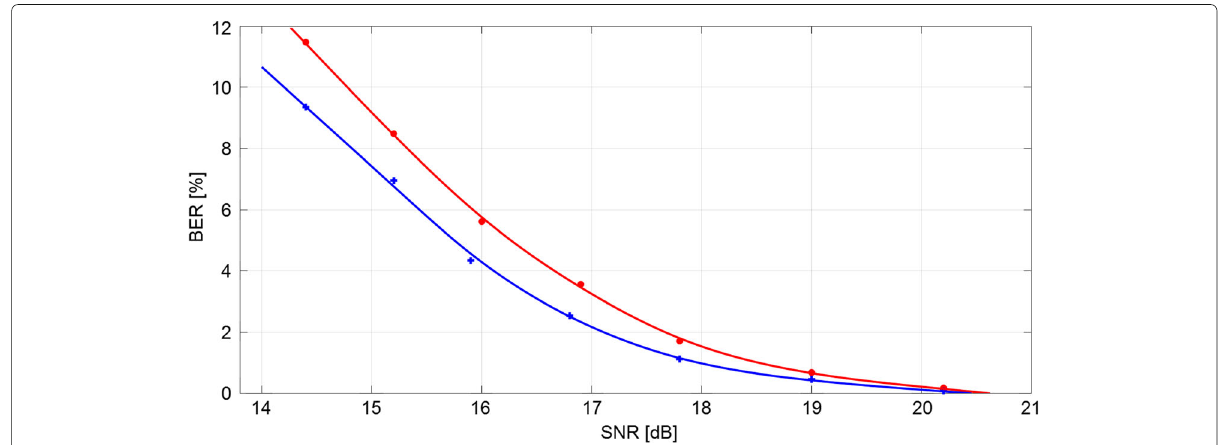
Fig. 1 Perfect reconstruction process: BER vs. SNR